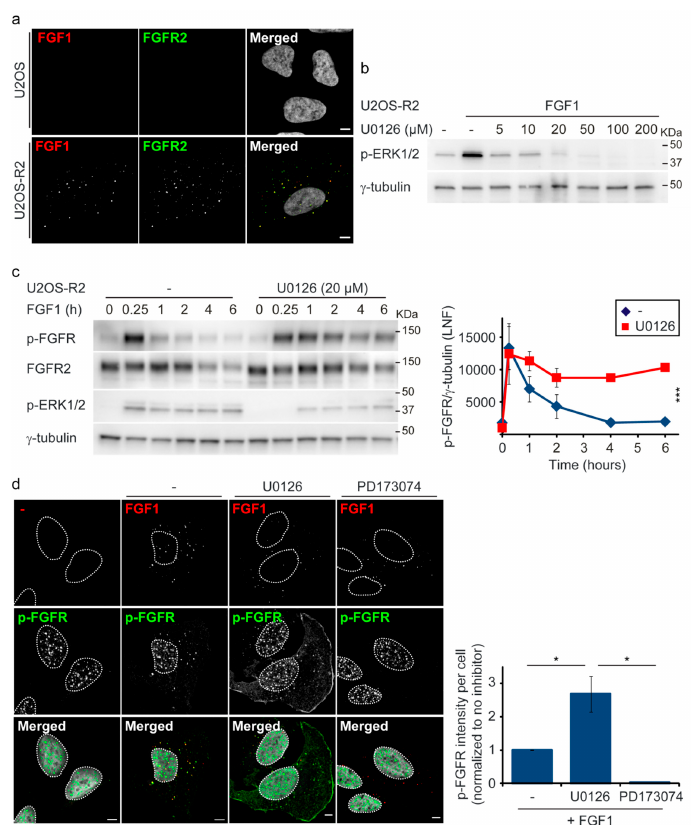
Figure 1. Inhibition of the ERK1/2 pathway prolongs FGFR2 signaling. ( a ) U2OS cells or U2OS cells stably transfected with FGFR2IIIc (U2OS ‐ R2) were treated with 200 ng/mL DL550 ‐ FGF1 in the